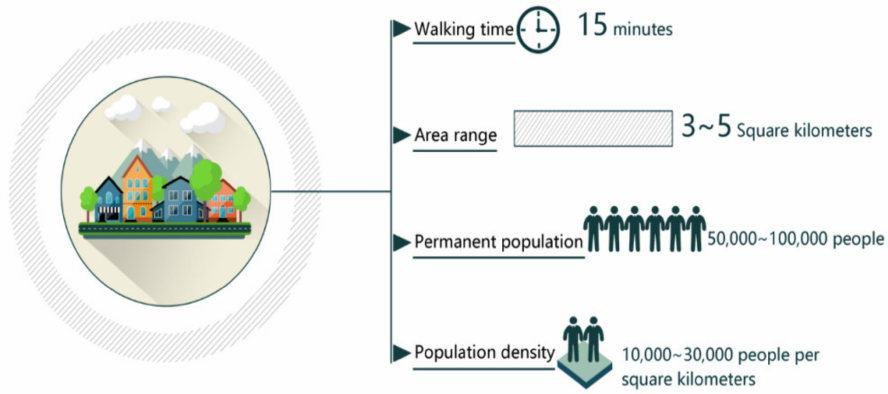
Figure 1. Basic living unit setting in